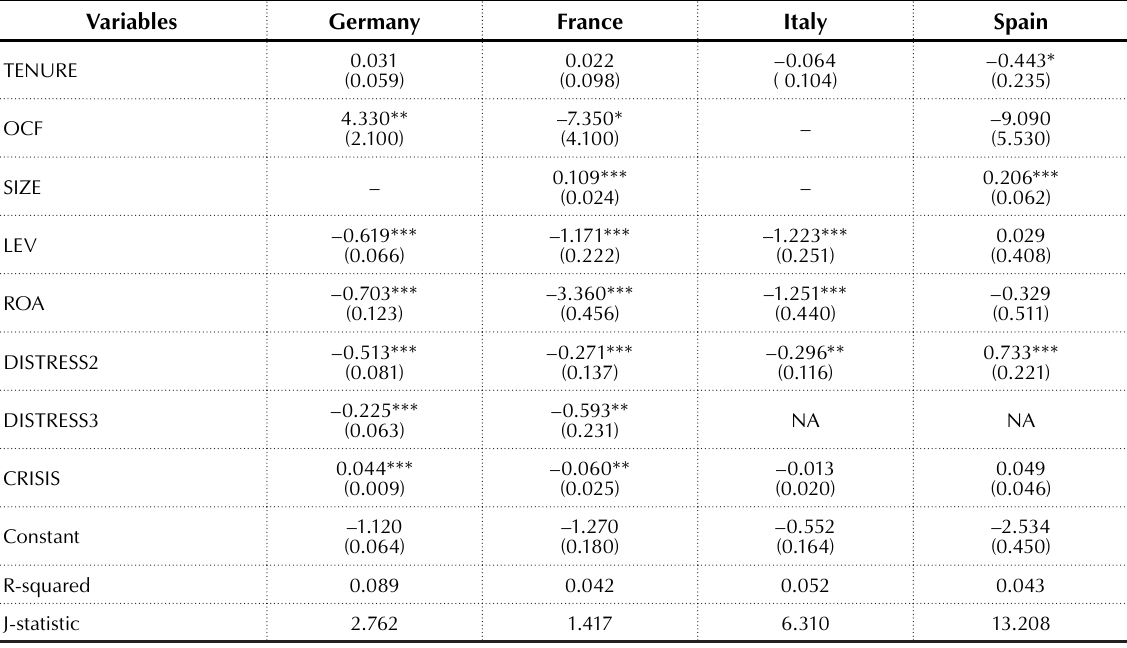
Table 3. GMM results for Germany, France, Italy and Spain